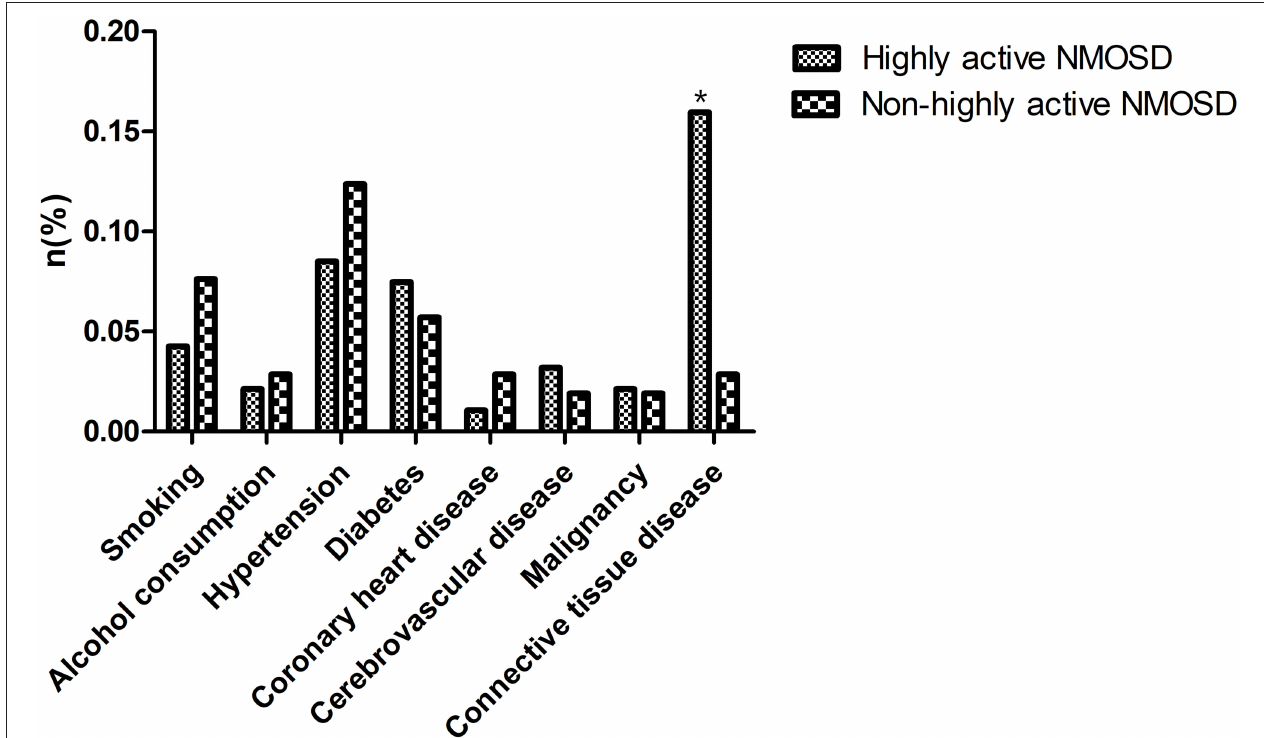
FIGURE 2 | Comorbidities of the patients. The prevalence of connective tissue disease was significantly higher among the patients with highly active NMOSD than non-highly active NMOSD. * P < 0.05.